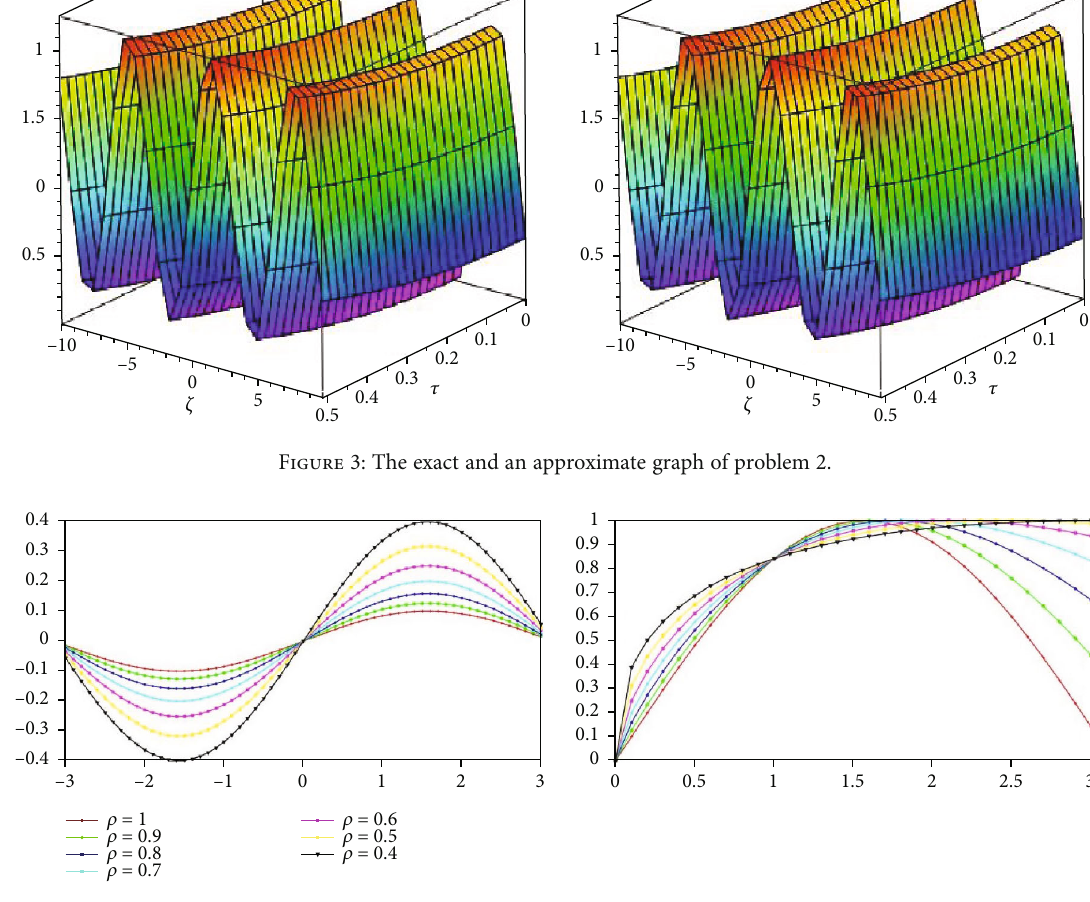
Figure 4: The di ff erent fractional-orders with respect to ζ and τ of problem